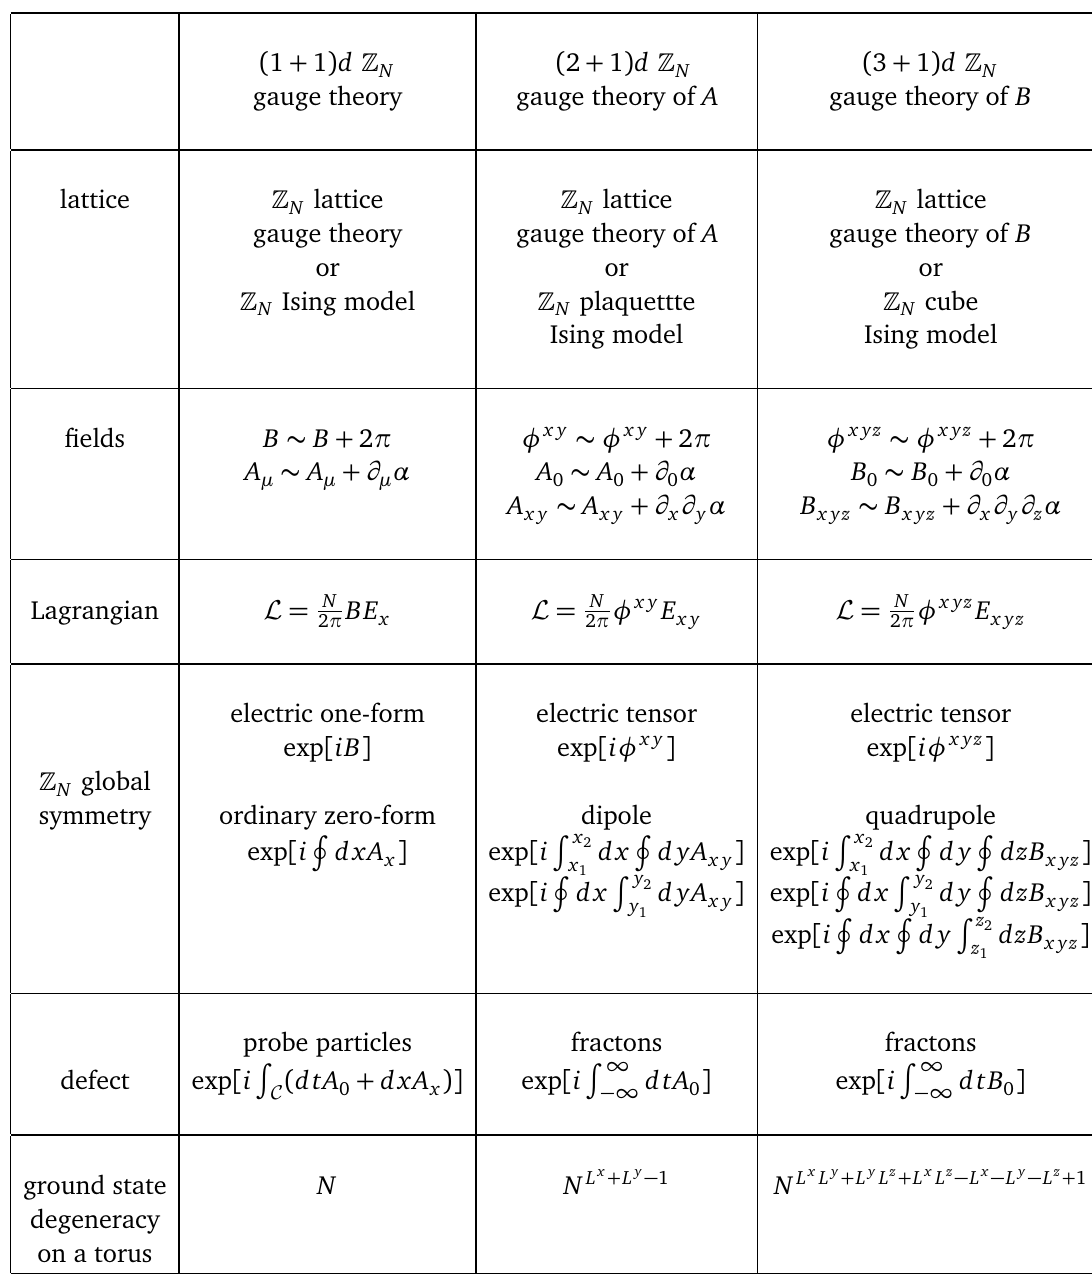
Table 3: Comparison between the ordinary 1 + 1-dimensional (cid:90) 2 + 1-dimensional (cid:90) gauge theory of A in [ 3 ] , and the 3 + 1-dimensional (cid:90) N theory of B in Section